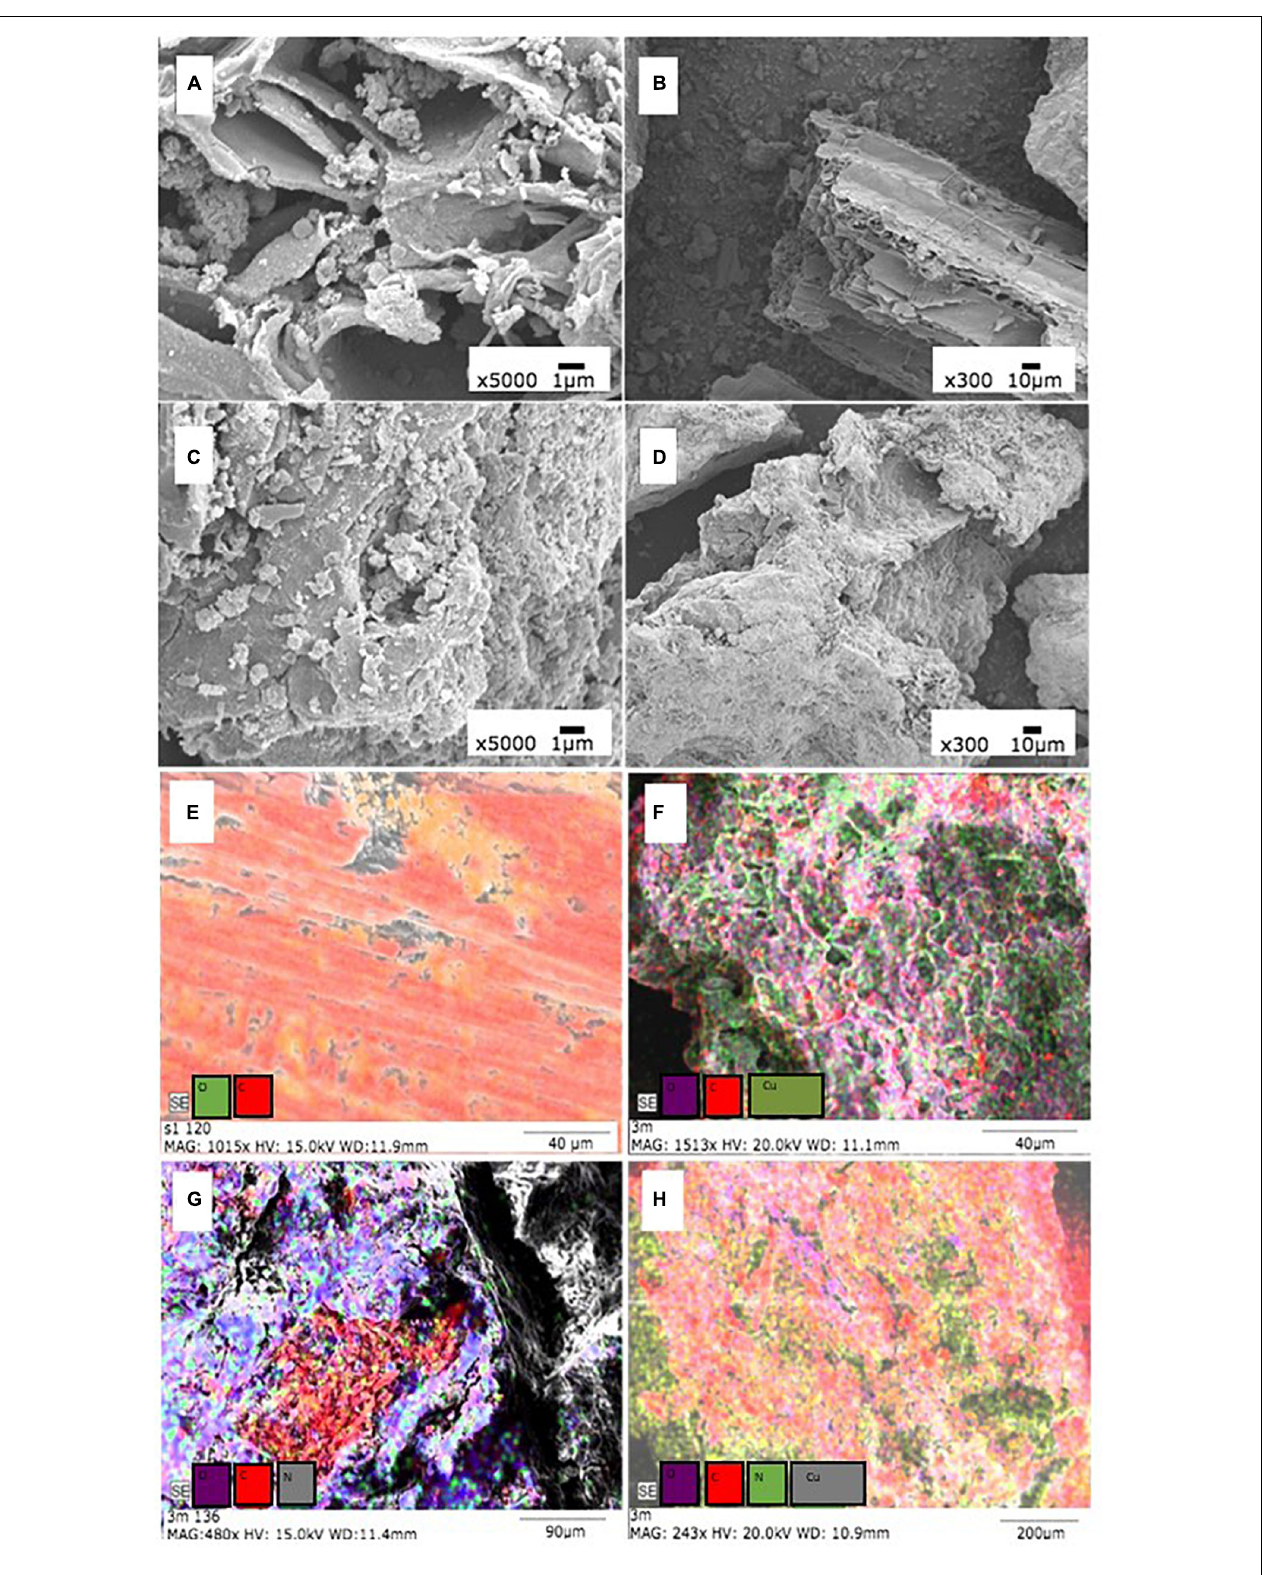
FIGURE 2 | SEM images of GBC (A,B) , CGBC (C,D) and EDX analysis of (E) GBC before adsorption and (F) GBC after Cu 2 + adsorption. Panel (G) is CGBC before adsorption and panel (H) is CGBC after Cu 2 + adsorption.